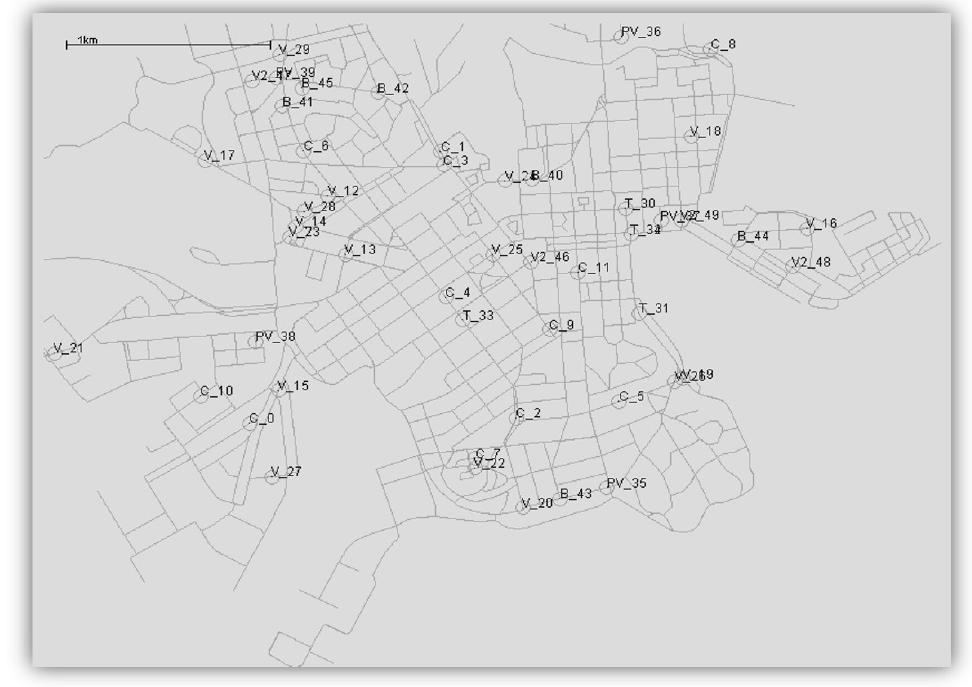
Table 3. Configuration settings of simulation tests.